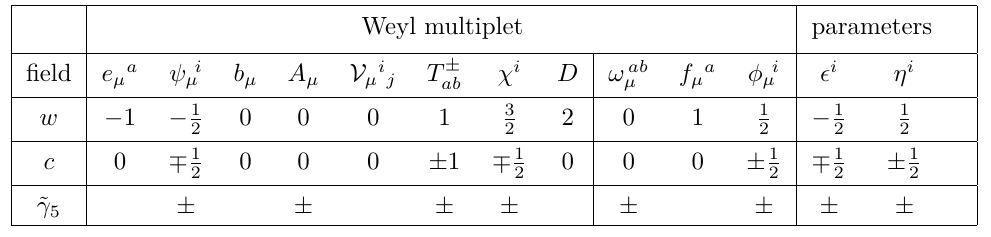
Table 3 . Weyl weights w , chiral SO(1 , 1) weights c , and chirality/duality ˜ γ 5 of the fields and spinors for the four-dimensional Euclidean Weyl